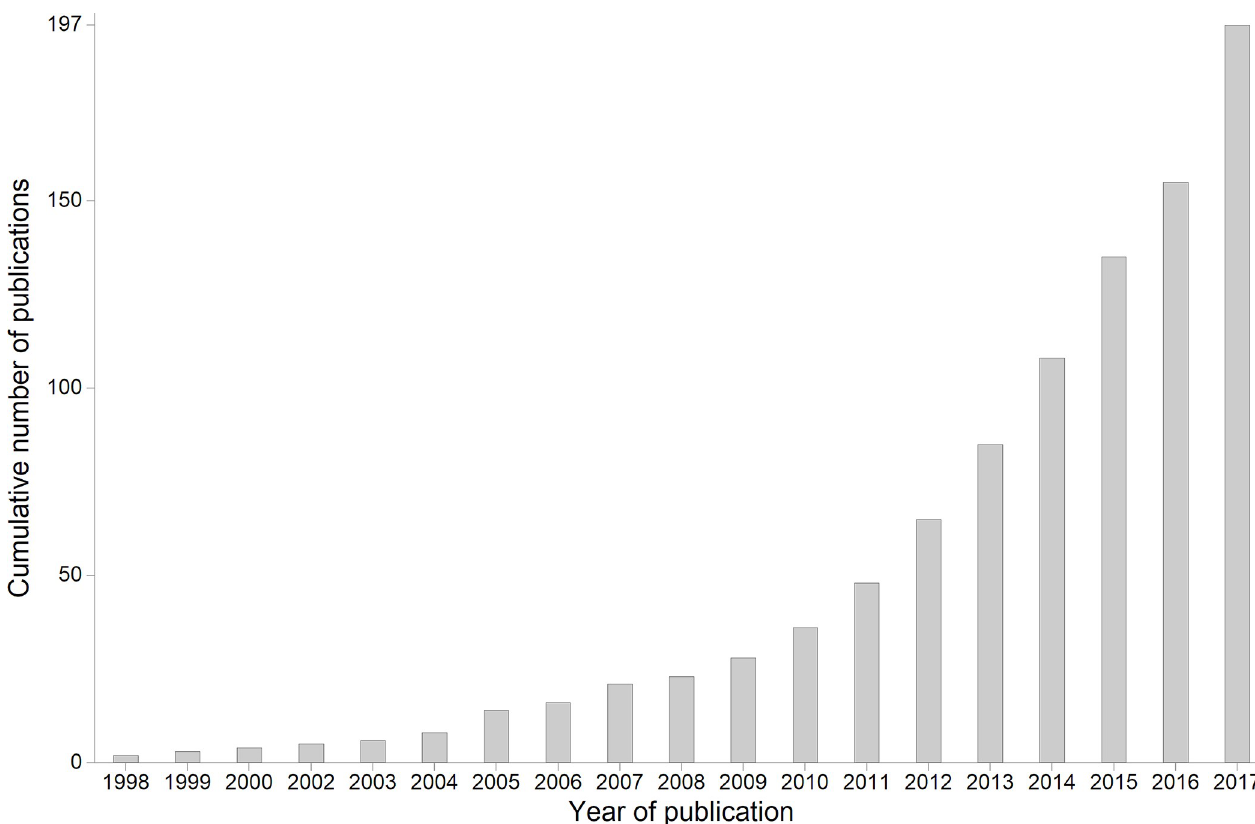
Fig 1. Cumulative number of publications targeting Romania’s grasslands that are accessible in the Scopus database (1998–2017).